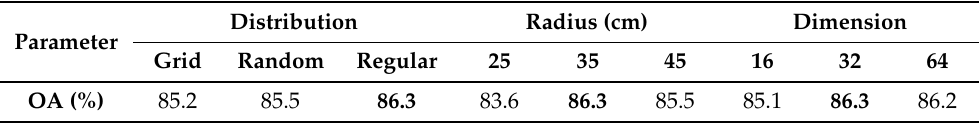
Table 7. The effect of the parameters of sample spheres on the classification of randomly-rotated objects from the ModelNet dataset [23] using the PointNet backbone